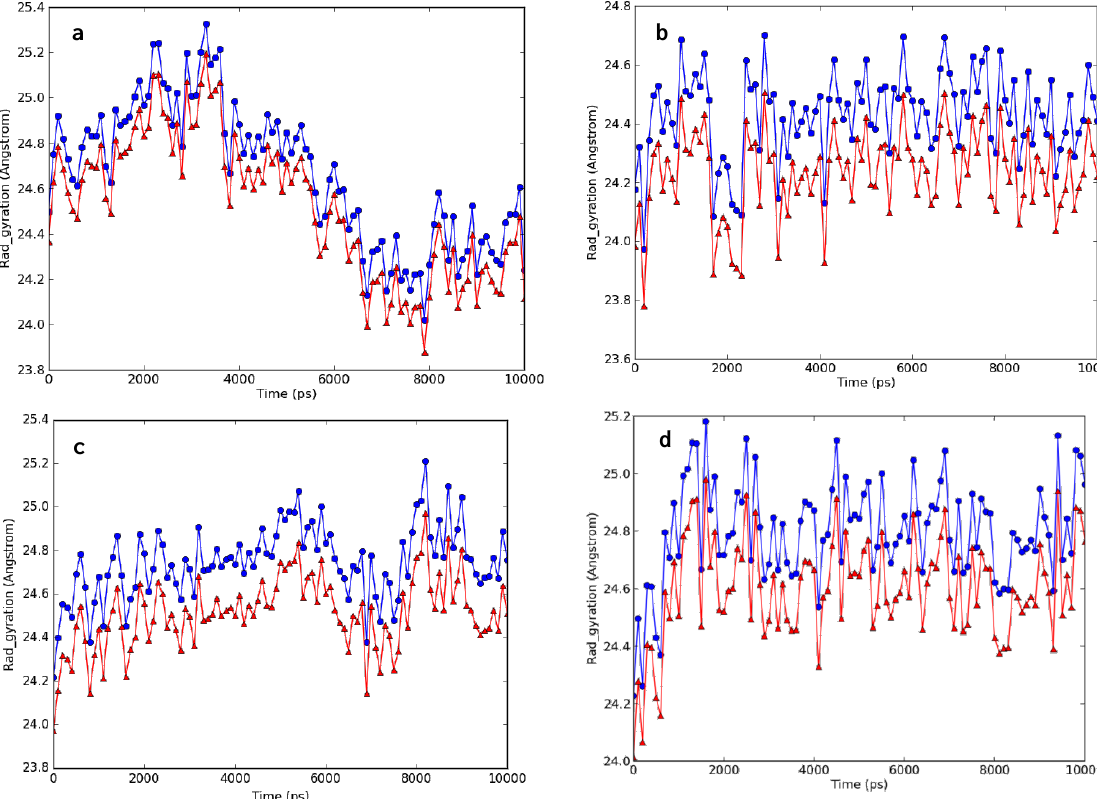
Figure S7. Radius of gyration of backbone (blue cirle) and C α atoms (red triangle) of (a) 10 , (b) 19 , (c) 21 and (d) 25 /1XFC complexes versus time at 300